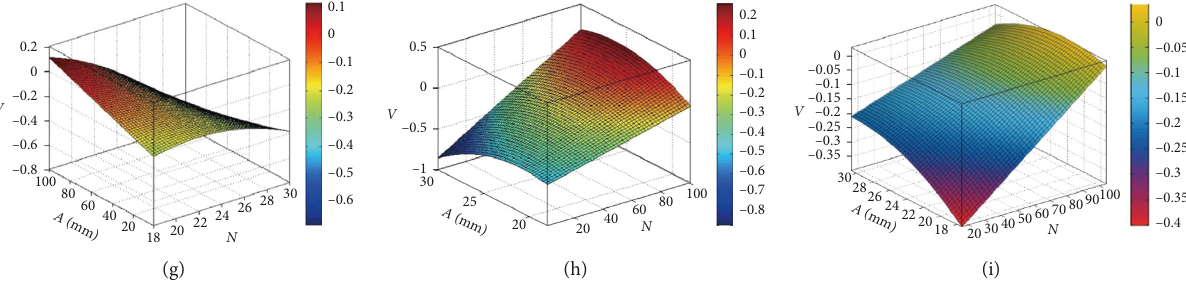
Figure 12: Damage-rate fitted surfaces of V M-1, M-4, M-7. (g) Z-3, Z-6, Z-9. (h) J-3, J-6, J-9. (i) M-3, M-6, M-9.